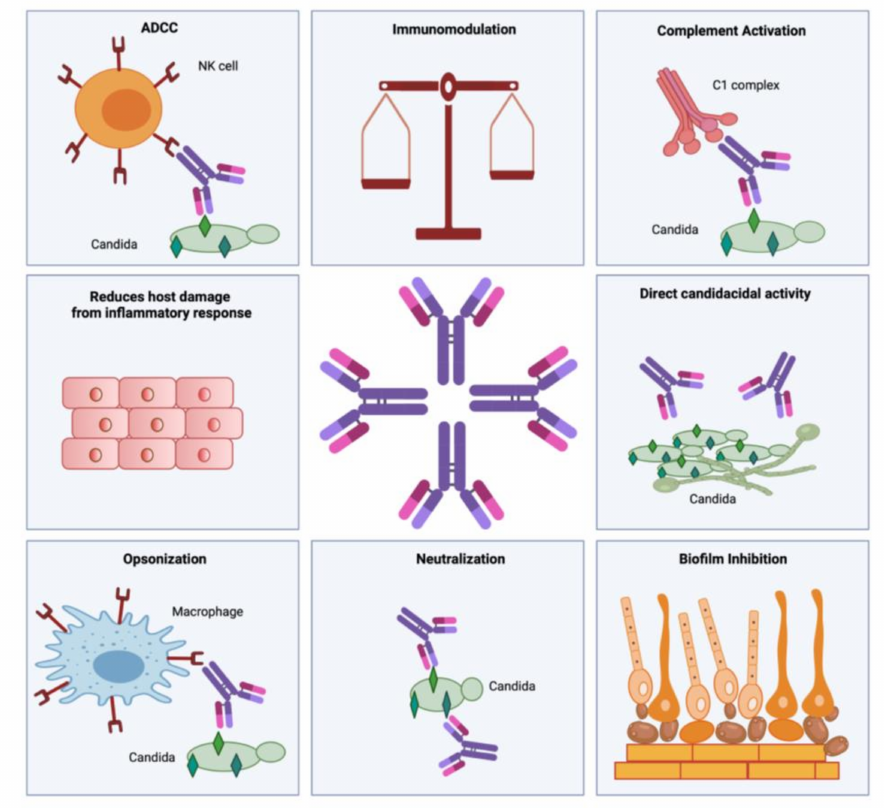
Figure 1. Schematic representation of antibody effector functions during invasive candidiasis. Anti- body functions include neutralization, opsonization, complement activation, antibody dependent cellular cytotoxicity (ADCC), inhibition of biofilm formation, direct anti-candidacidal activity, im- munomodulation and reduction of inflammatory damage. (Created with